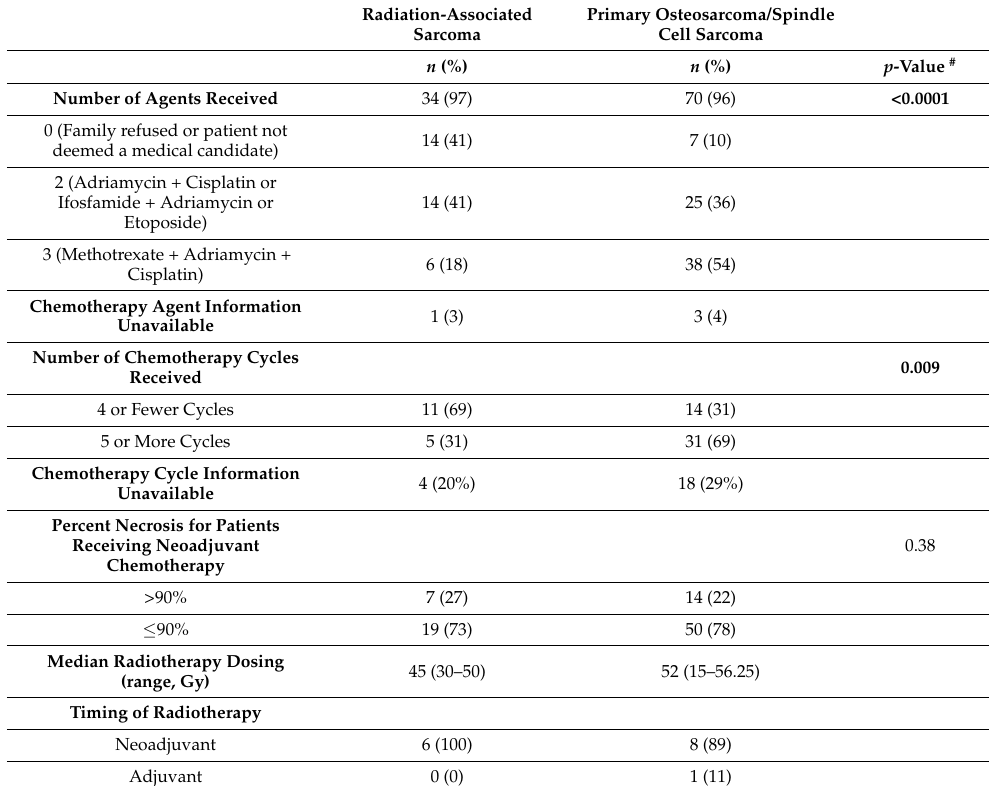
Table 3. Adjuvant regimens utilized for patients with localized radiation-associated sarcoma of the pelvis and sacrum and primary localized osteosarcoma/spindle cell